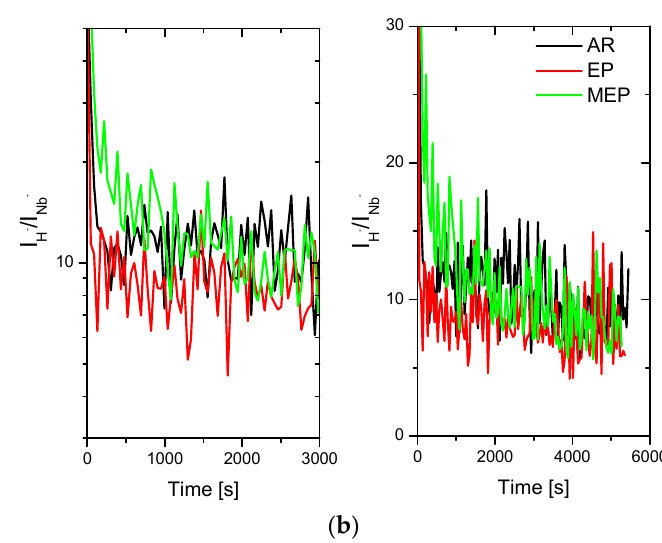
Figure 4. Dependence of ratios of secondary ions current of hydrogen to secondary ions current of niobium on the time of ionic etching. Etching time of 5500 s corresponds with the thickness of niobium etched layer equaling a few hundreds of nanometers; in ( a ) there are given ratios of positive secondary ions currents, and in ( b ) ratios of negative secondary ions currents.